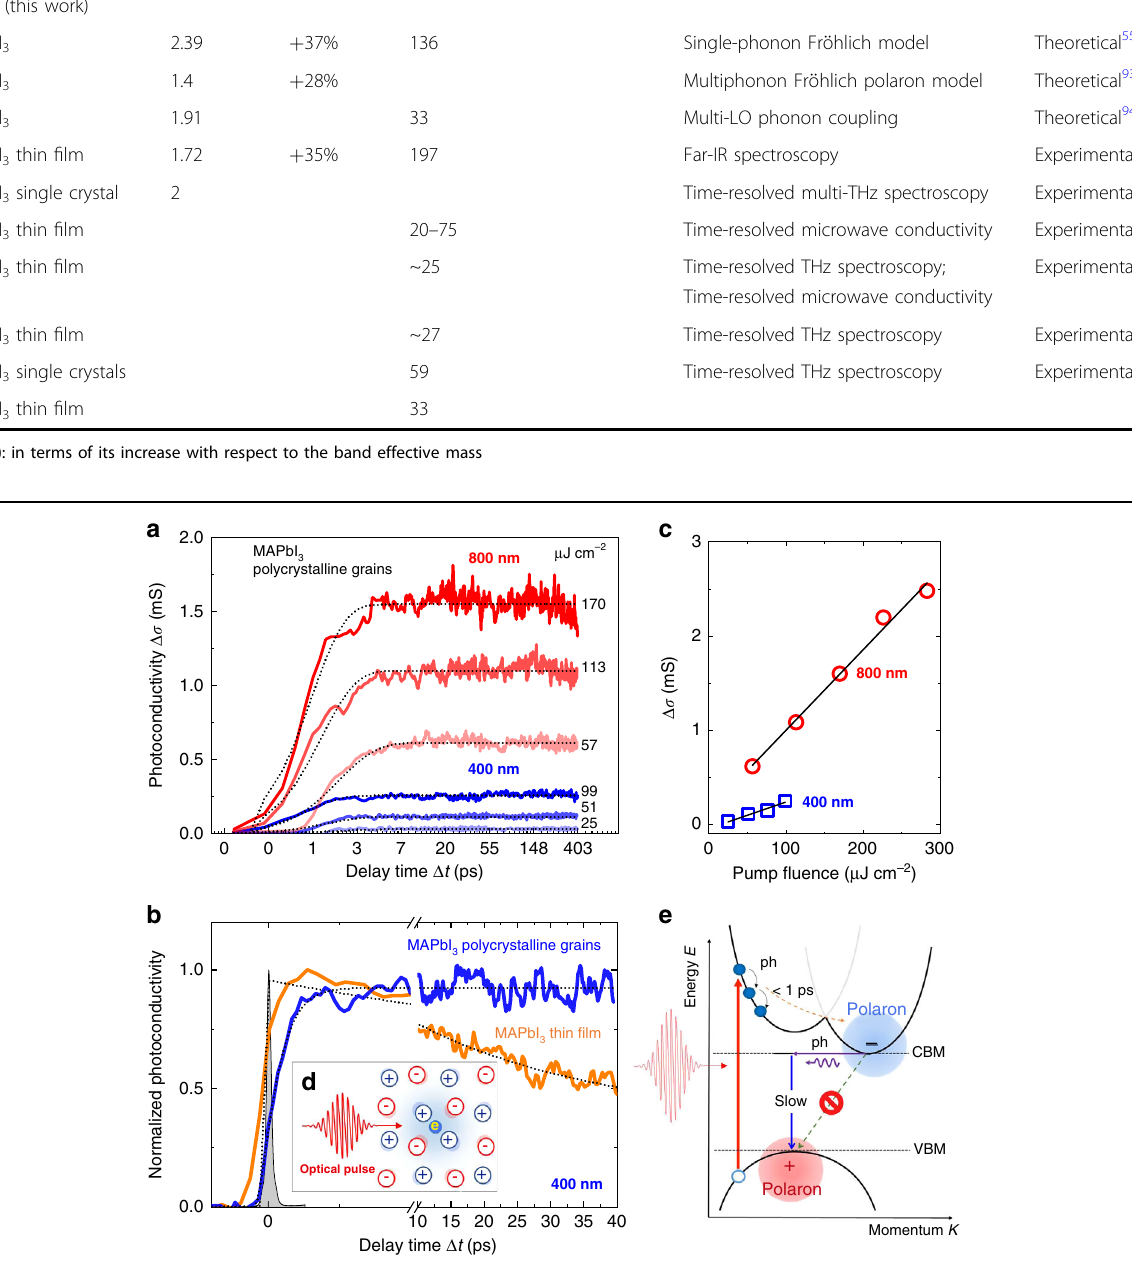
Fig. 4 Ultrafast large polaron formation and relaxation dynamics of MAPbI 3 . a The transient THz photoconductivity of the MAPbI 3 polycrystalline grains measured at 800nm (red) and 400nm (blue) laser excitations, as plotted in the log scale. b Time-resolved THz photoconductivity dynamics normalized to 1, for two different samples, using excitation of 400nm wavelength. The gray pro fi le represents the pump pulse. c The pump fl uence dependences of the quasi-steady-state THz photoconductivity. The solid line is a fi t to the data linearly. d A large polaron in MAPbI 3 looks like a lump of negative charge that attracts MA + cations and repels halide anions. e A proposed band diagram and photoexcitation dynamics in MAPbI